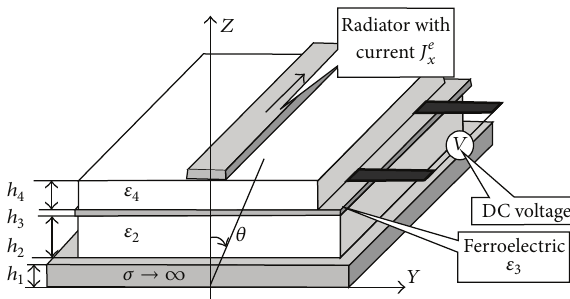
Figure 17: Slotted waveguide antenna [34].